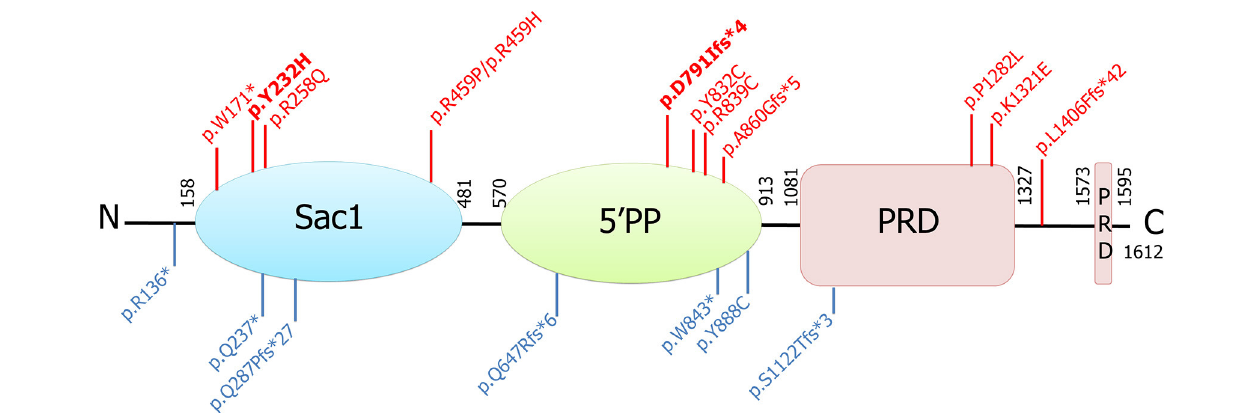
FIGURE 2 | Schematic representation of the longer isoform of the synaptojanin 1 protein, its functional domains, and all associated mutations identified to date. Those found in patients with parkinsonism are shown in red (in bold, those identified in this study), and those found in patients with intractable seizures and severe neurodegeneration are shown in blue. Sac1, suppressor of actin (Sac1-like inositol domain); 5 ′ PP, inositol-5 ′ -phosphatase domain; PRD, prolin-rich